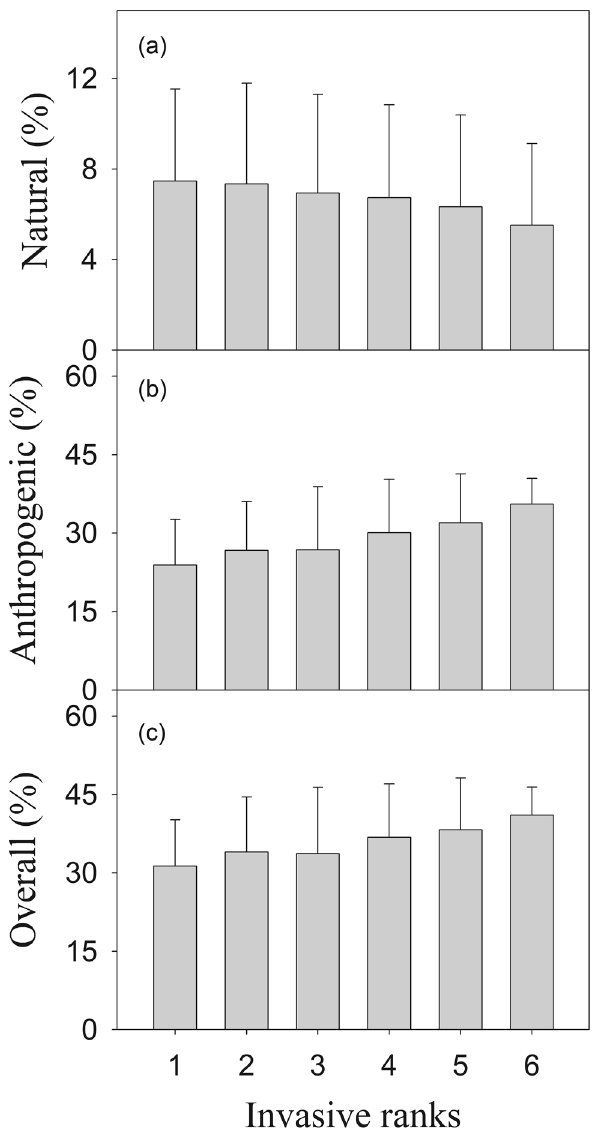
serious invaders; ( III ) rank III: local invaders; ( IV ) rank IV: mild invaders; ( V ) rank V: species requiring further observation; and ( VI ) rank VI: cultivated alien species. The plot was drawn by SigmaPlot 10.0 (https:// systat- sigma plot.